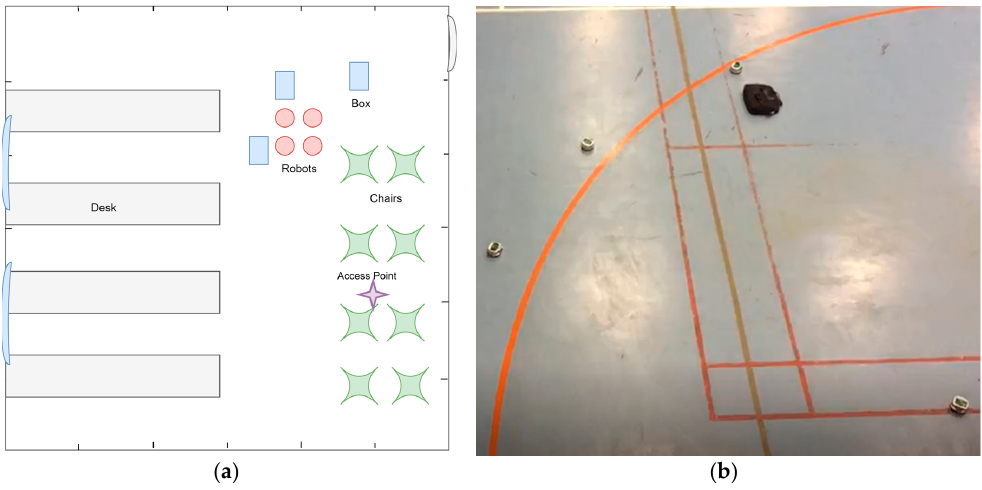
Figure 2. Samples of the environments used for experimental testing: ( a ) a sketch of a heavily obstructed small office space (training/meeting room); ( b ) a snapshot of a lightly obstructed large open space (gymnasium).